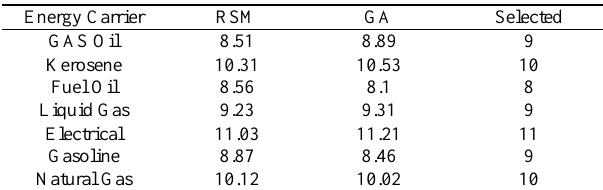
Table 4. Optimized number of neurons for the created networks.